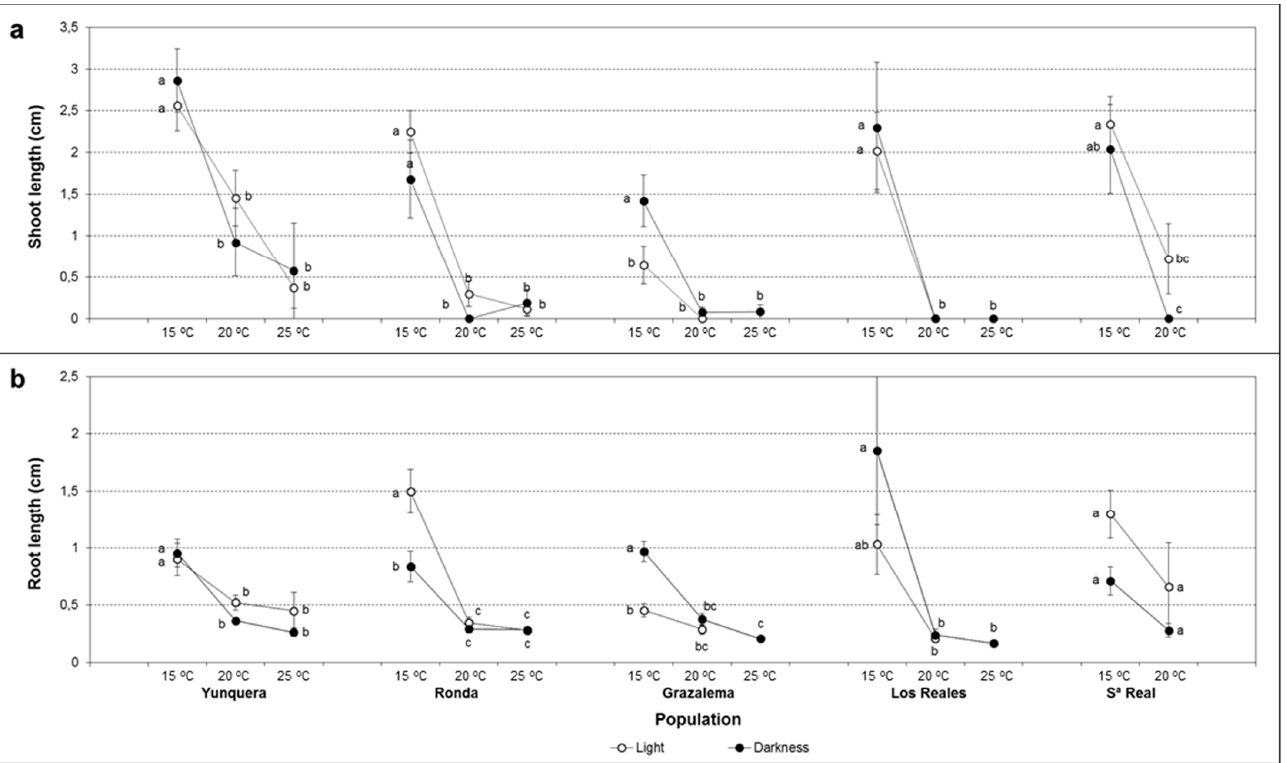
Figure 3. Effect of temperature and light on ( a ) shoot and ( b ) root length of seedlings obtained from A. pinsapo seeds from different provenances. Data represent the mean ± SEM. Different letters within each population indicate significant differences by the LSD test with a significance level of 0.05.